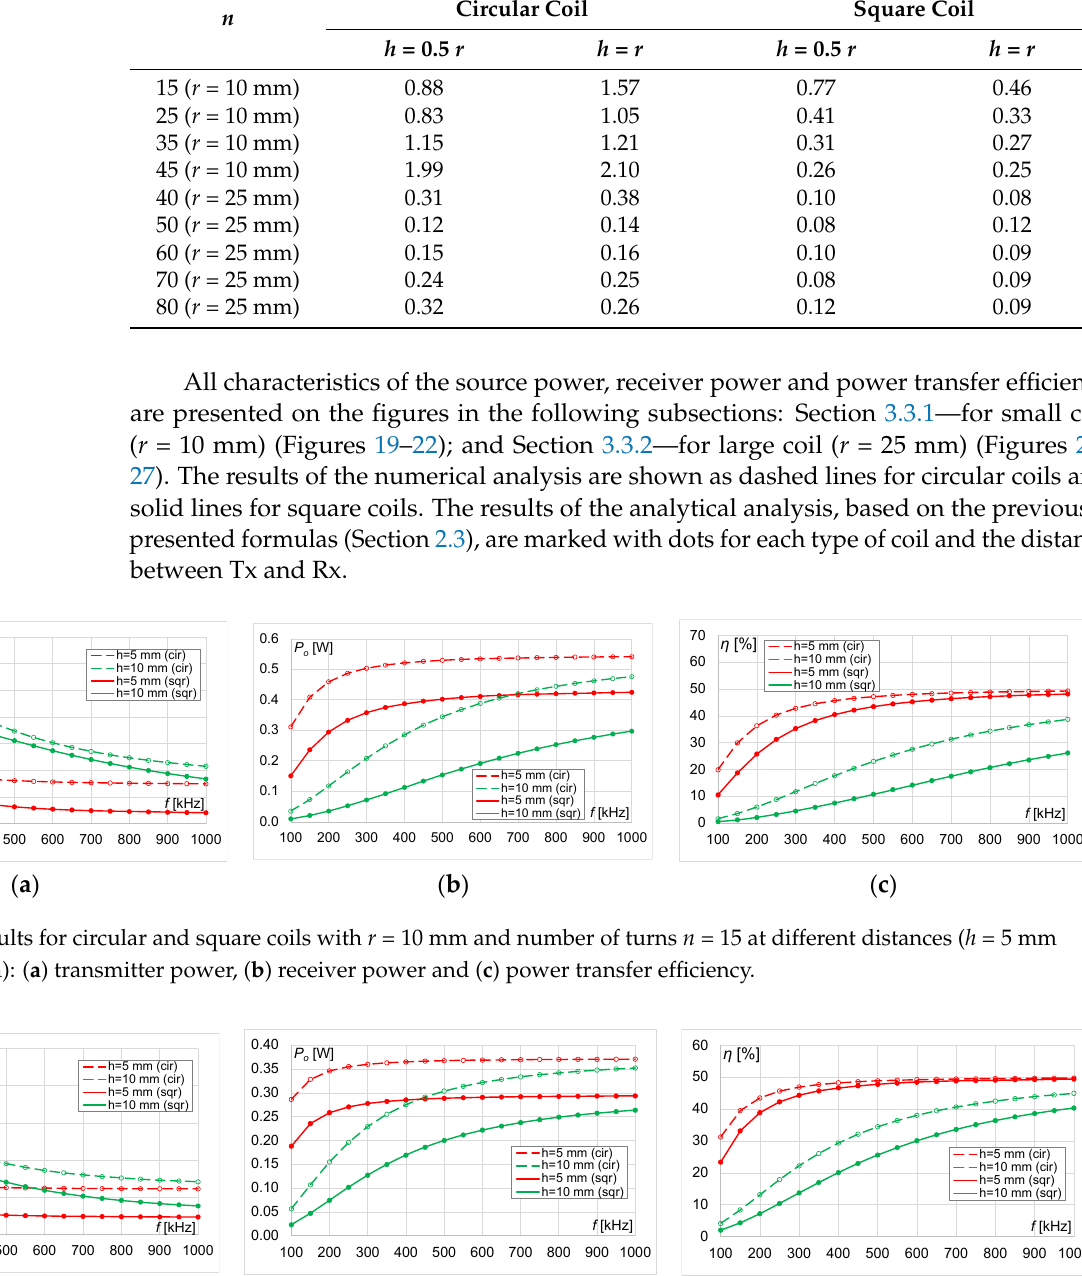
Figure 20. Results for circular and square coils with r = 10 mm and number of turns n = 25 at different distances ( h = 5 mm and h = 10 mm): ( a ) transmitter power, ( b ) receiver power and ( c ) power transfer efficiency.